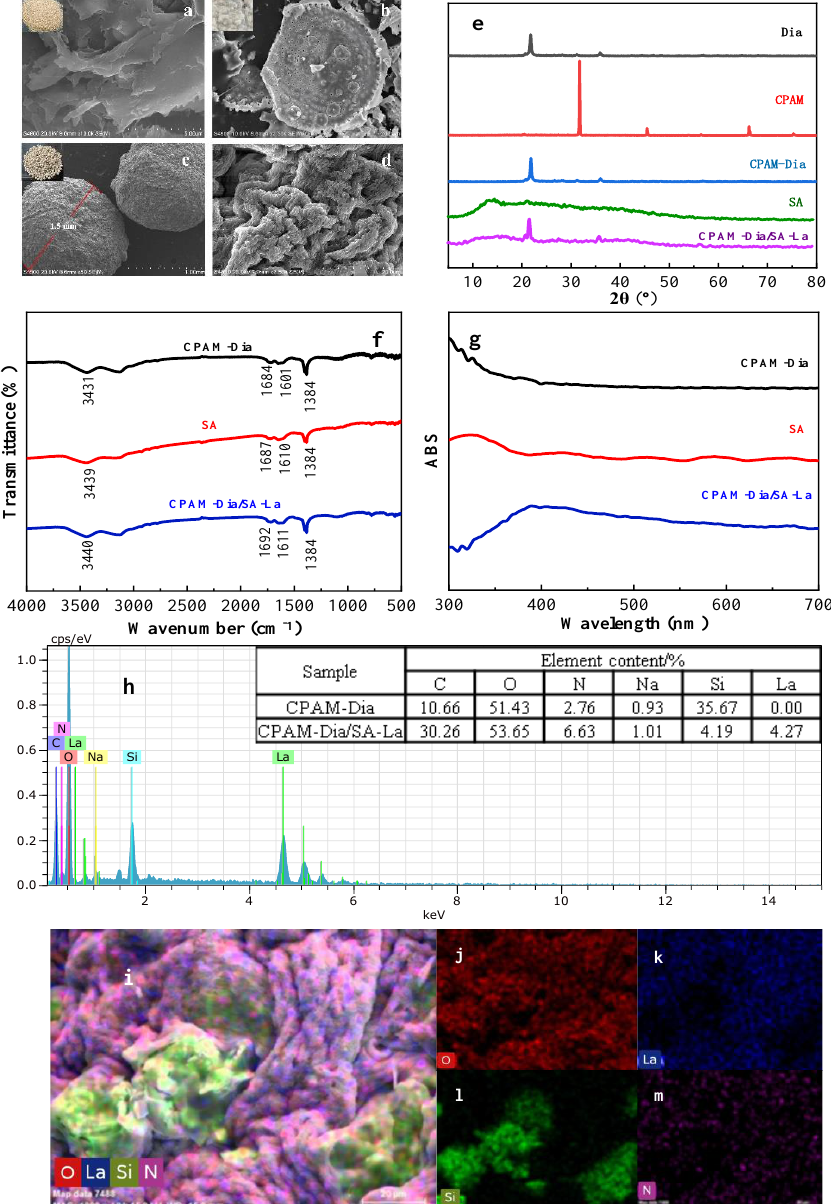
Figure 2. SEM images of SA ( a ), Dia ( b ) and gel spheres ( c , d ); XRD ( e ), FT − IR ( f ) and UV − Vis ( g ) spectra; EDS results of raw materials and gel spheres ( h ); Element distribution of the gel composite ( i – m ).